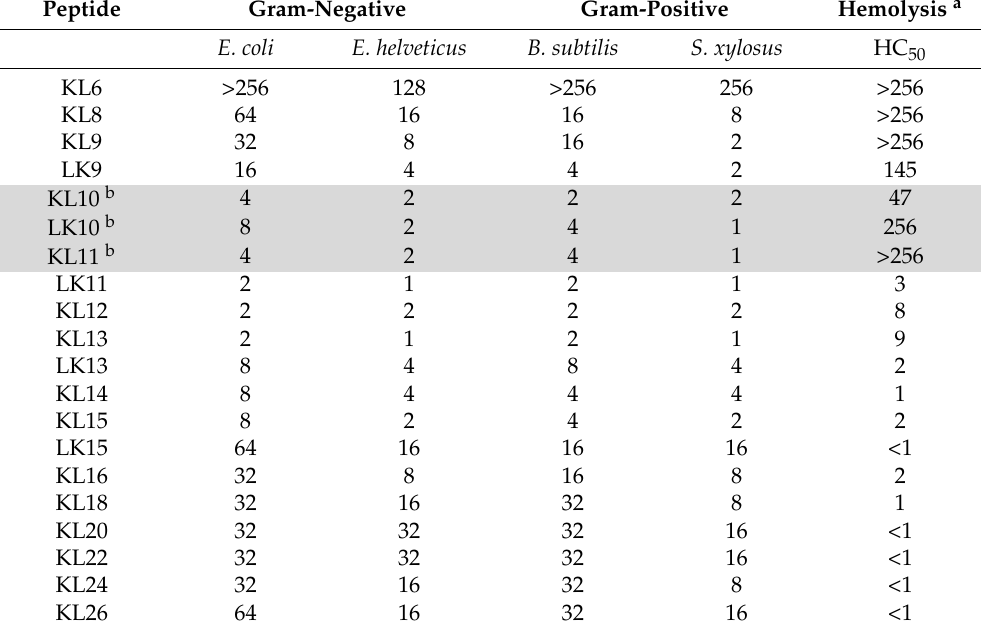
Table 2. MIC values for KL peptides against four bacterial strains and HC 50 data ( µ g/mL).